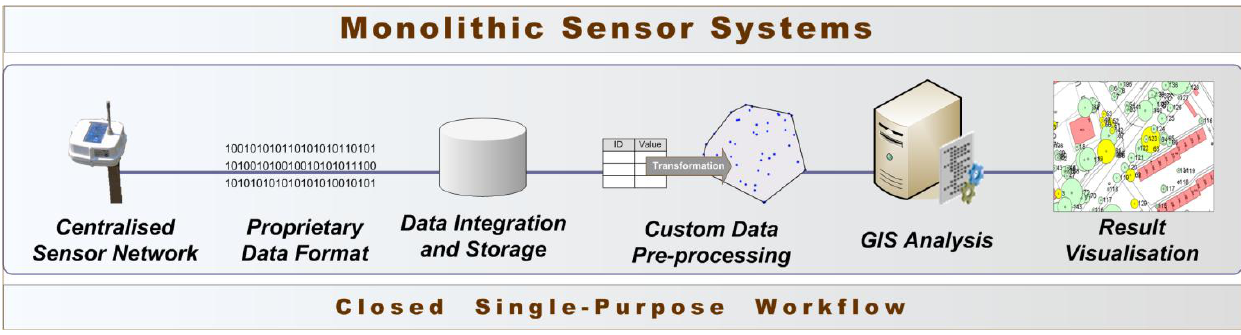
Figure 1. Current Approach—Monolithic Single-purpose Sensor